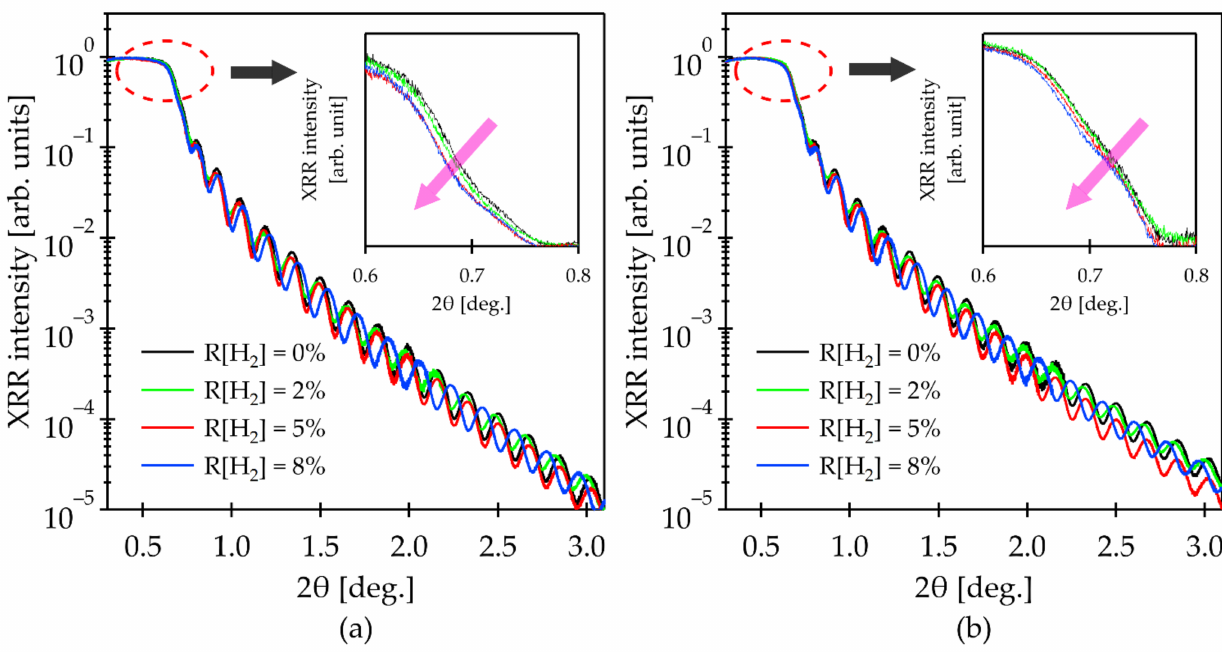
Figure 5. XRR results of the IGZO films deposited at different R[H 2 ] and at fix R[O 2 ] of 1%: ( a ) as- deposited; ( b ) after annealing in air for 1 h at the annealing temperature of 150 ◦ C. The insets show